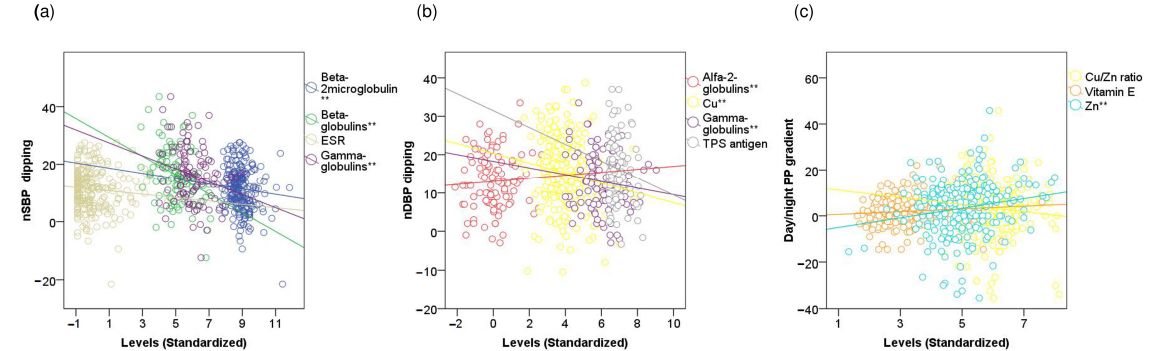
Figure 3. Linear correlations of 24-h day to night blood pressure indices with inflammatory and redox markers. The Scatter plots represent the correlations between 24-h day-to-night blood pressure indices and inflammatory and redox markers. Correlation coefficients and standard errors are shown in Supplementary Table S1. ( a ) Nocturnal SBP dipping. ( b ) Nocturnal DBP dipping. ( c ) Day-to-night PP gradient. SBP—Systolic blood pressure. DBP—Diastolic blood pressure. nSBP—Average night-time SBP. nDBP—Average night-time DBP. Day/night—day-to-night. PP—Pulse pressure. ESR—Erythrocyte sedimentation rate. TPS—Tissue polypeptide specific. Cu—Copper. Zn—Zinc. ** refers to p -value of lower than